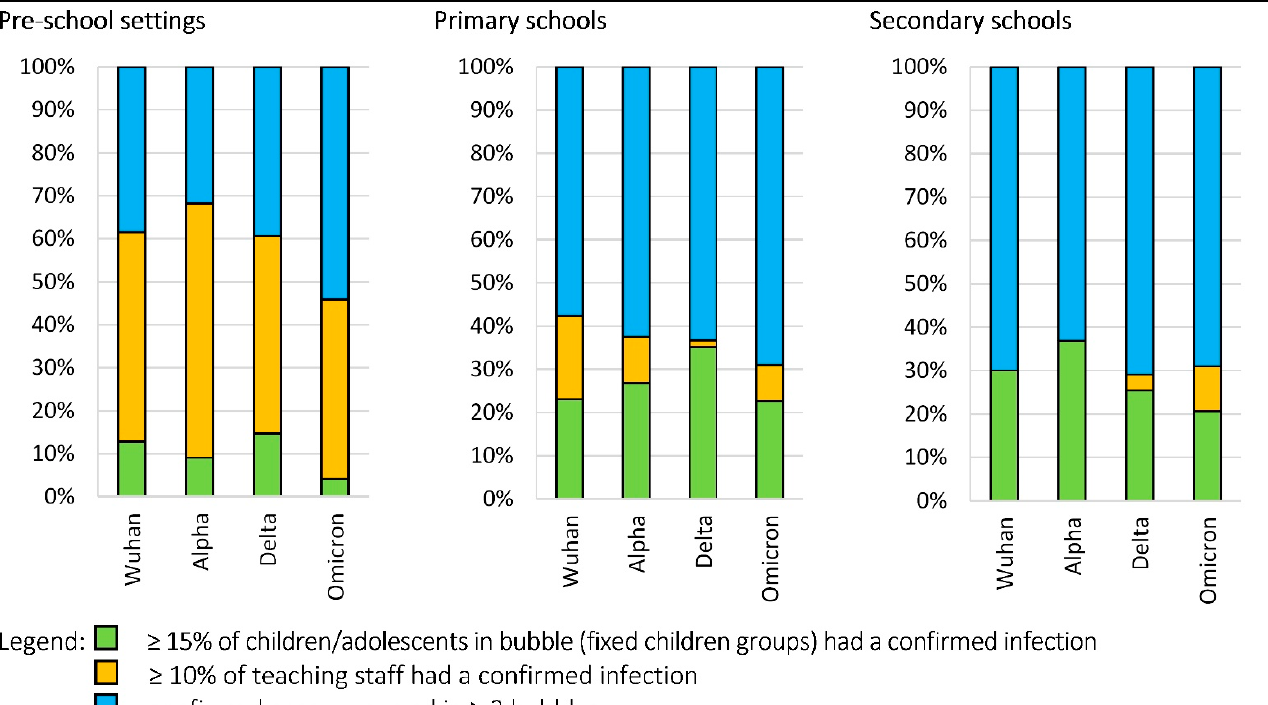
Figure 2. Representation of the fulfilled COVID-19 outbreak criteria in educational settings in Slovenia in the period from 26 January 2021 to 18 January 2022, taking into account the periods of prevalence of each SARS-CoV-2 variant in Slovenia.